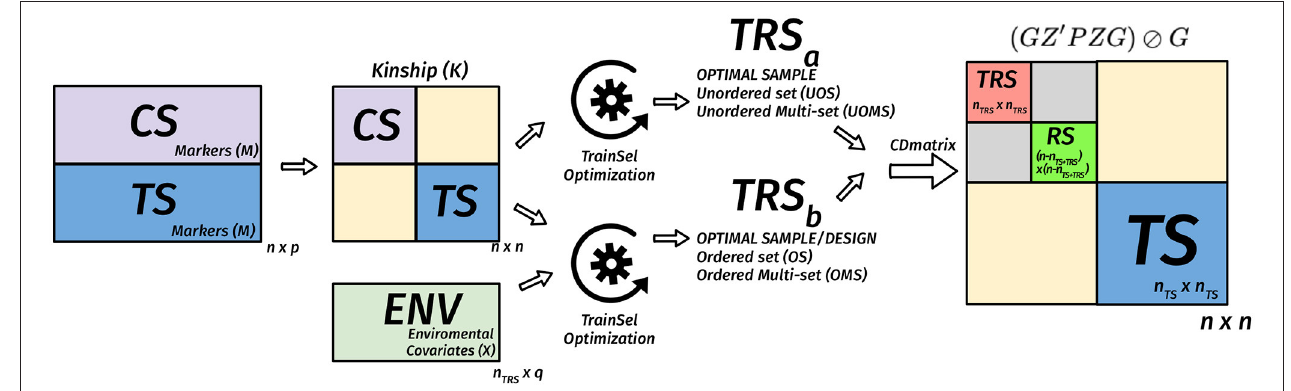
FIGURE 3 | Diagram of the matrix of the CD criterion in the TRS optimization for unordered and ordered experiments for the targeted case. We assume that we have n TS genotypes in the TS, n − n TS genotypes in the CS, n TRS genotypes are selected to the TRS from the CS. In this case, the n × n kinship matrix is used to calculate the n × n CD matrix for a given TRS, then the mean CD is calculated based on certain diagonals that correspond to TS. The optimization algorithm is used to find the best TRS. When provided with a design matrix that has heterogeneous rows, then we are also looking for a design in addition to the selection of a TRS. In this case, both the kinship matrix and the n TRS × q environmental covariates matrix are used to calculate the n × n CD matrix for a given TRS, then the mean CD is calculated based on diagonals that correspond to TS. The optimization algorithm is used to find the best TRS and best design with this TRS.